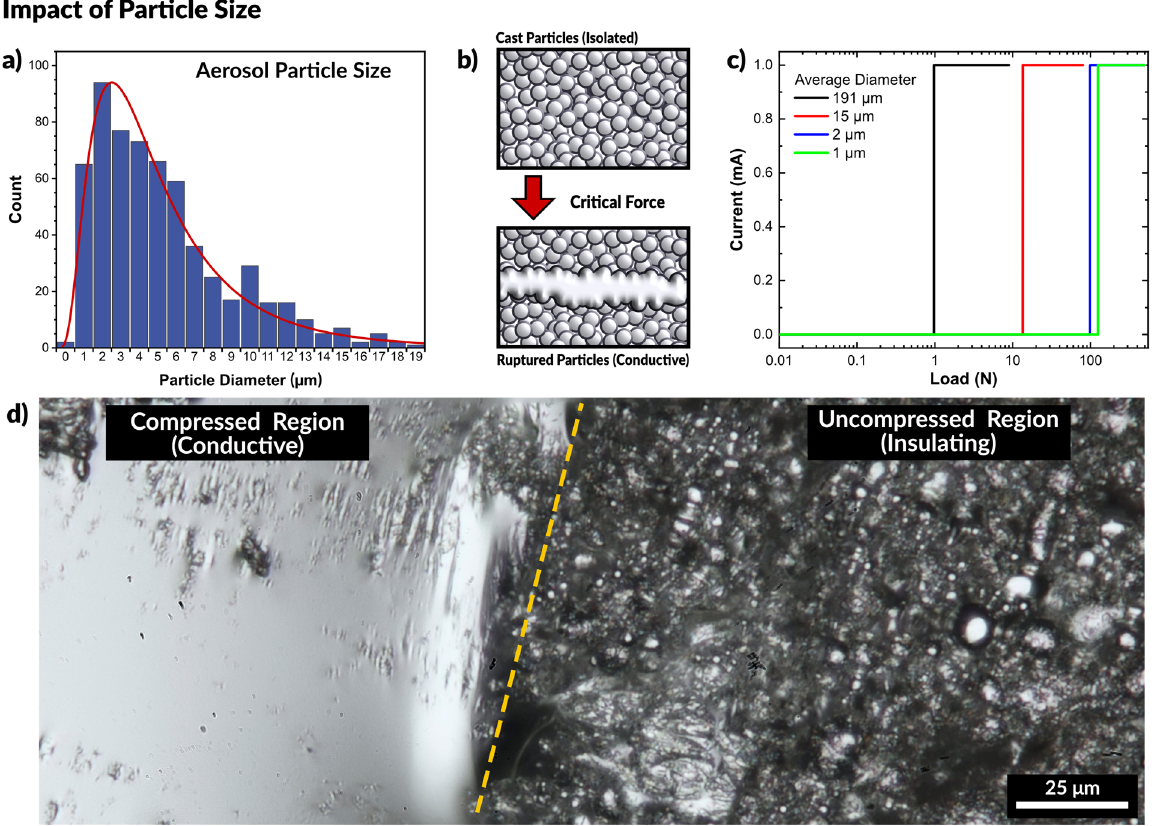
Figure 3. ( a ) Particle size distribution of aerosolized liquid metal. ( b ) Schematic of experiment where force is applied to a cast film of liquid metal particles. With sufficient force the particles rupture and merge to form a conductive path. ( c ) Plot of measured current across a liquid metal particle film as a function of applied pressure. Smaller particles require greater force to rupture and form a conductive path, seen by the load at which the current increases by a step-change. ( d ) Optical micrograph of the boundary between the compressed region and uncompressed particles of a cast film. The compressed region is conductive while the uncompressed regions remain insulating.